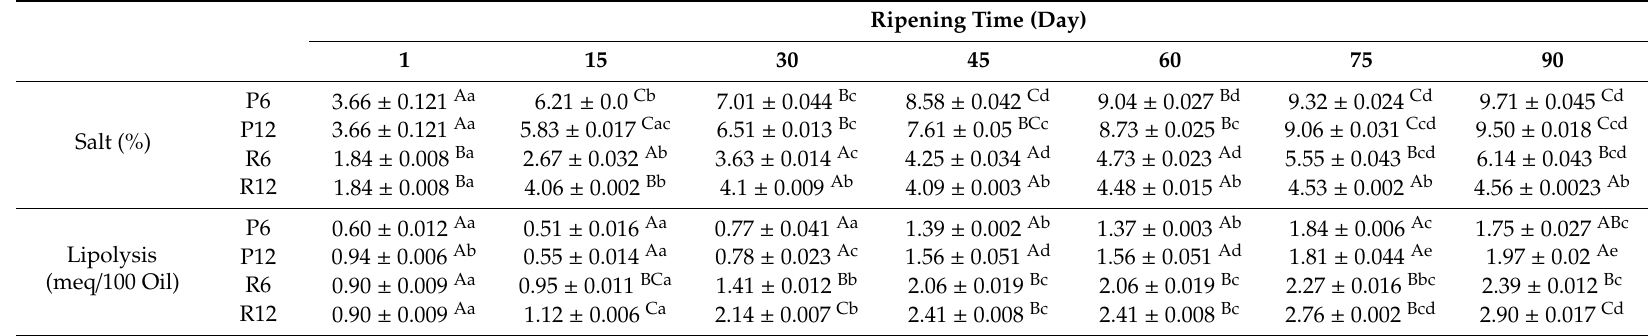
Table 2. Physicochemical properties of Motal cheese during the 90-day ripening